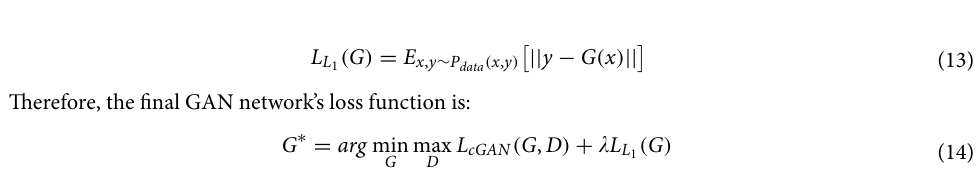
Figure 3. Main components of generative adversarial network ( a ) generator network; ( b ) discriminator